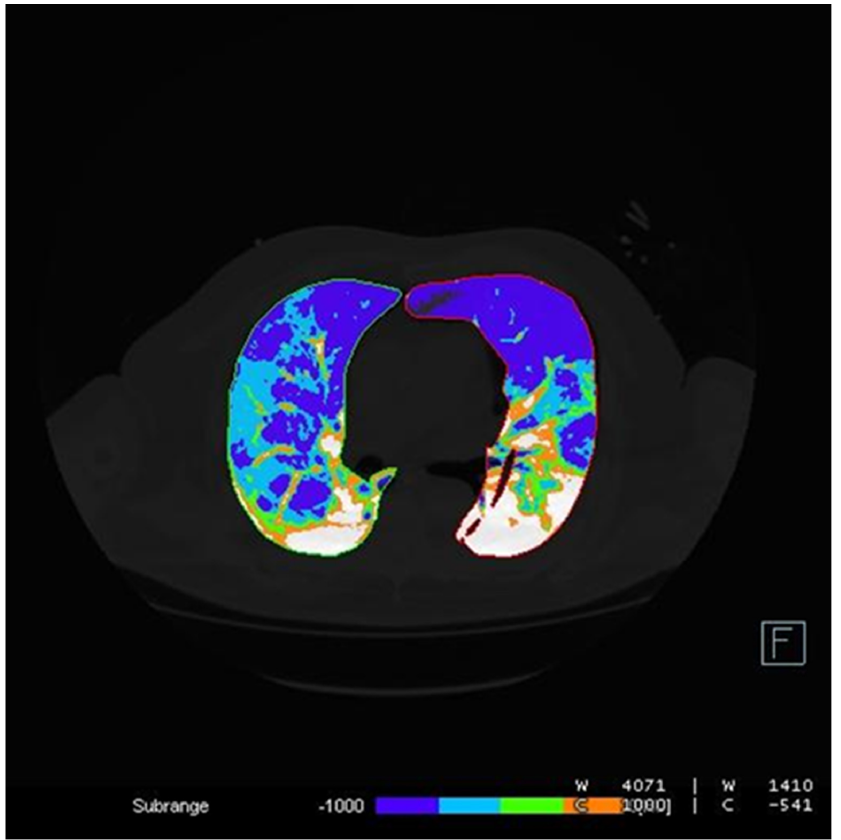
Figure 8. CT Pulmo 3D: lung contouring. This figure shows the lung parenchyma lesions counted; the different colors employed suggest different HU sub-ranges. the different colors employed suggest different HU